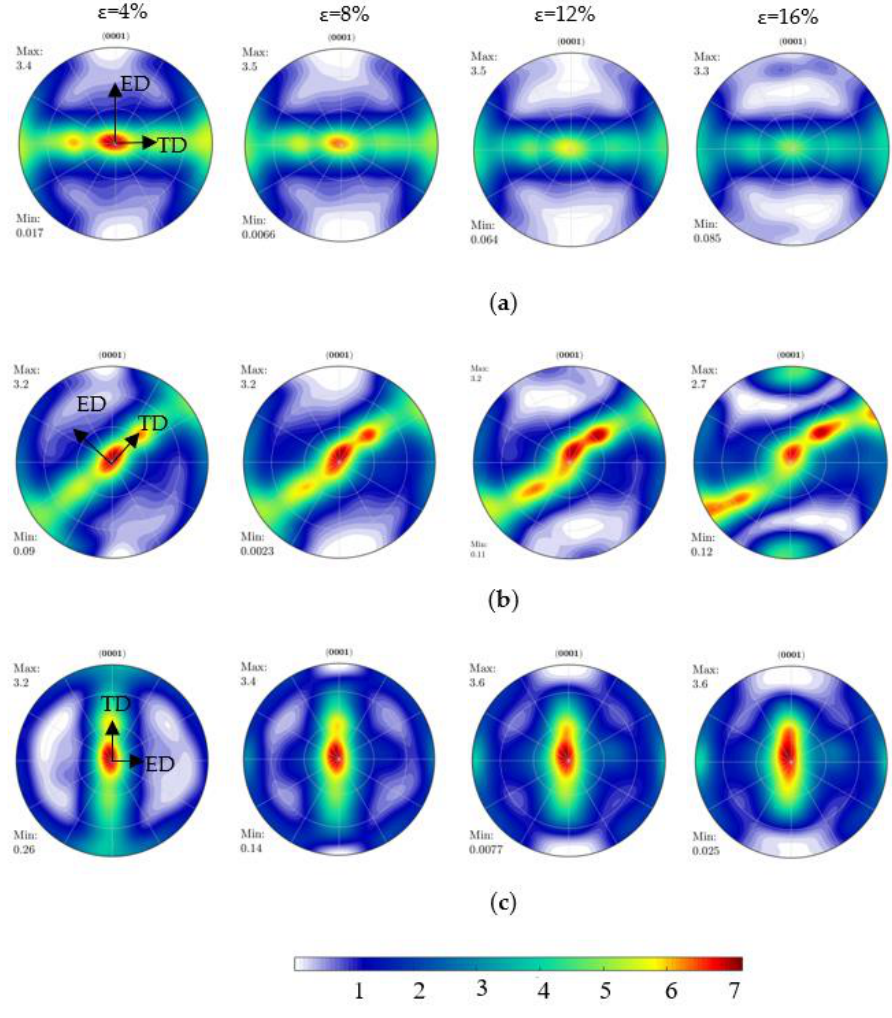
Figure 9. Predicted texture evolution of {0001} pole figure of different samples under axial tension to different strain values: ( a ) T0 sample, ( b ) T45 sample, ( c ) T90 sample.